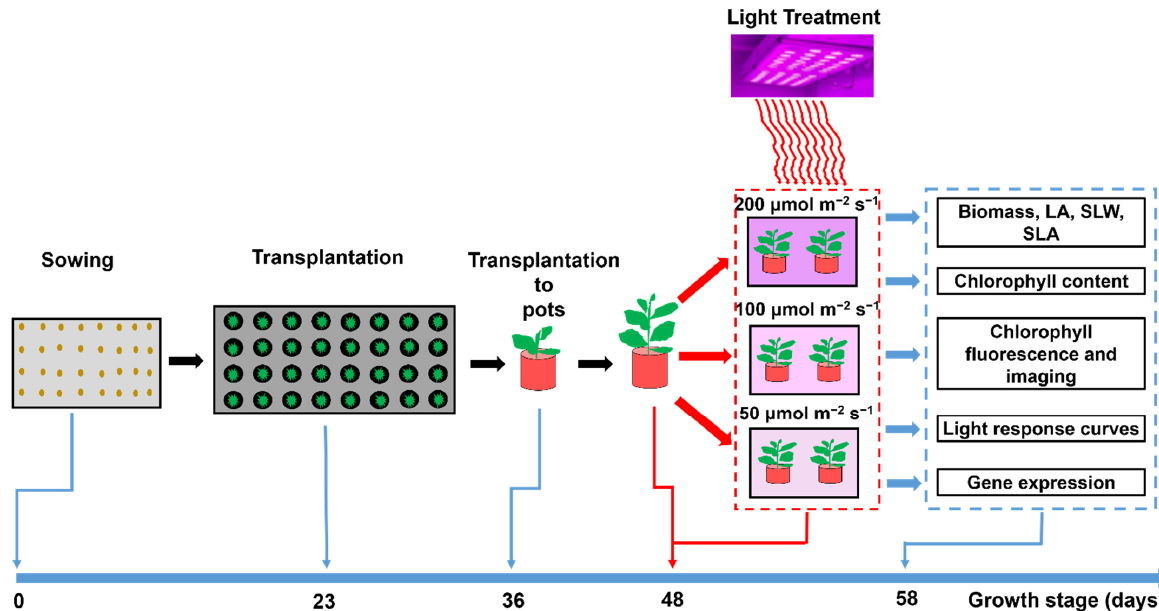
Figure 1. This schematic flow shows the arrangement of the experiment. The cigar tobacco seedlings are grown under normal conditions and then subjected to different light intensities. The seedlings are kept for ten days under different light intensities. The different light intensities are 200 μ mol m − 2 s − 1 , 100 μ mol m − 2 s − 1 , and 50 μ mol m − 2 s − 1 .